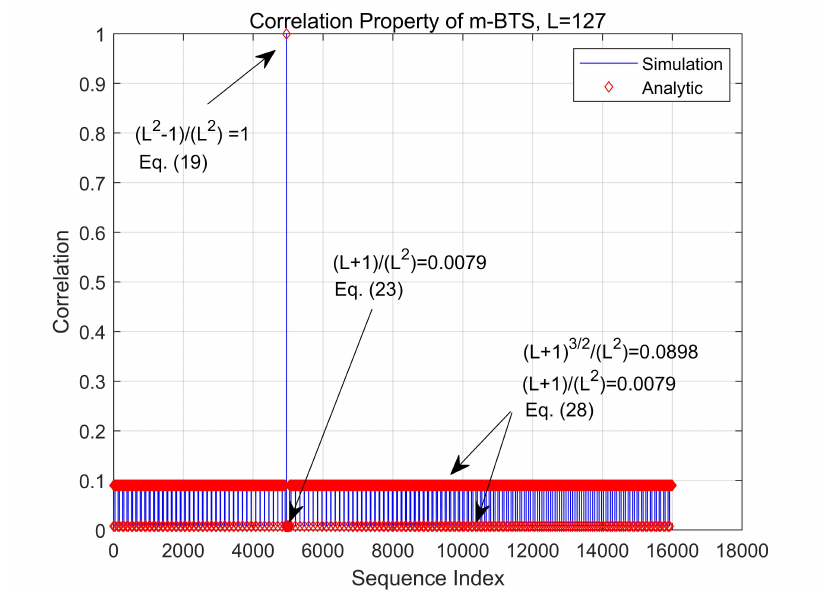
Figure 3. Correlation property of the m-BTS (STO =